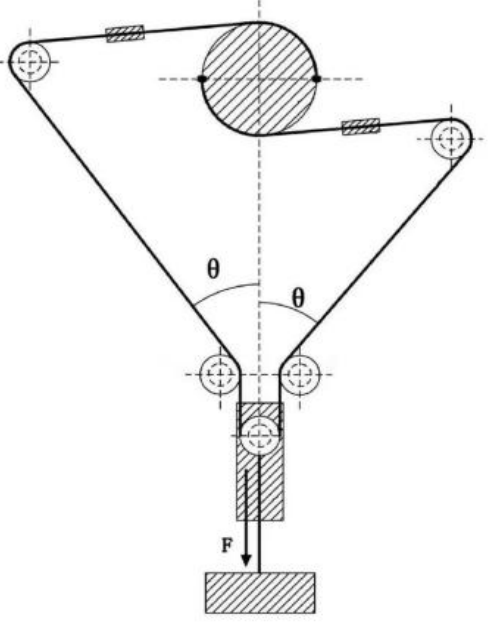
Figure 2. Measuring device for friction resistance at spherical hinge interface.